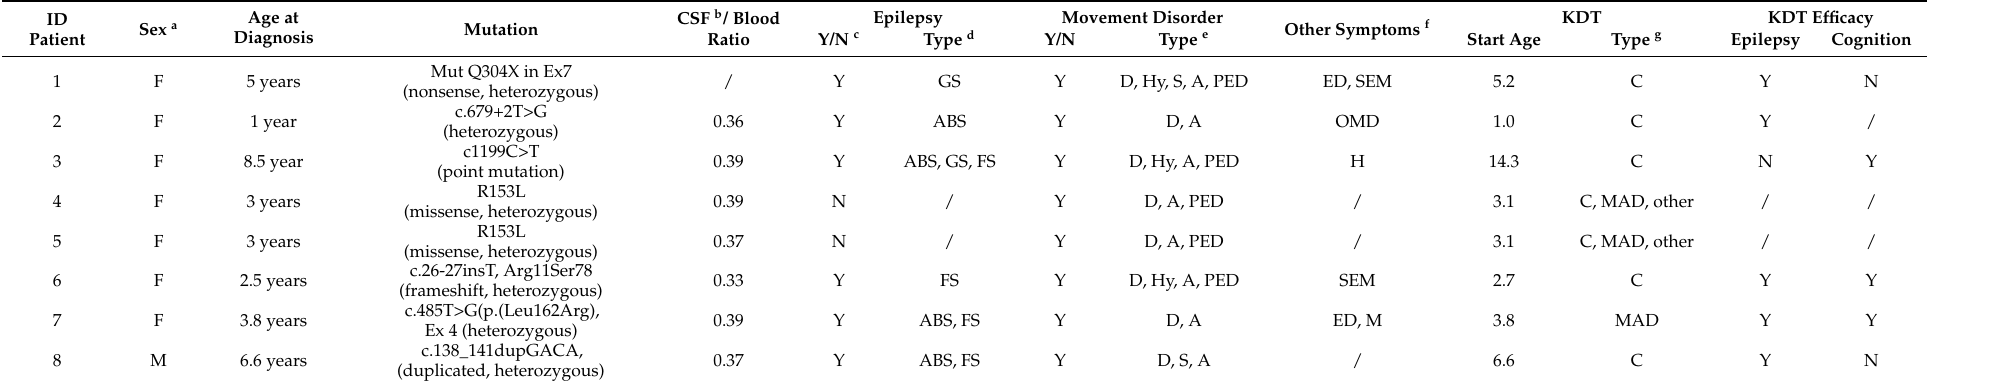
Table 1. Clinical